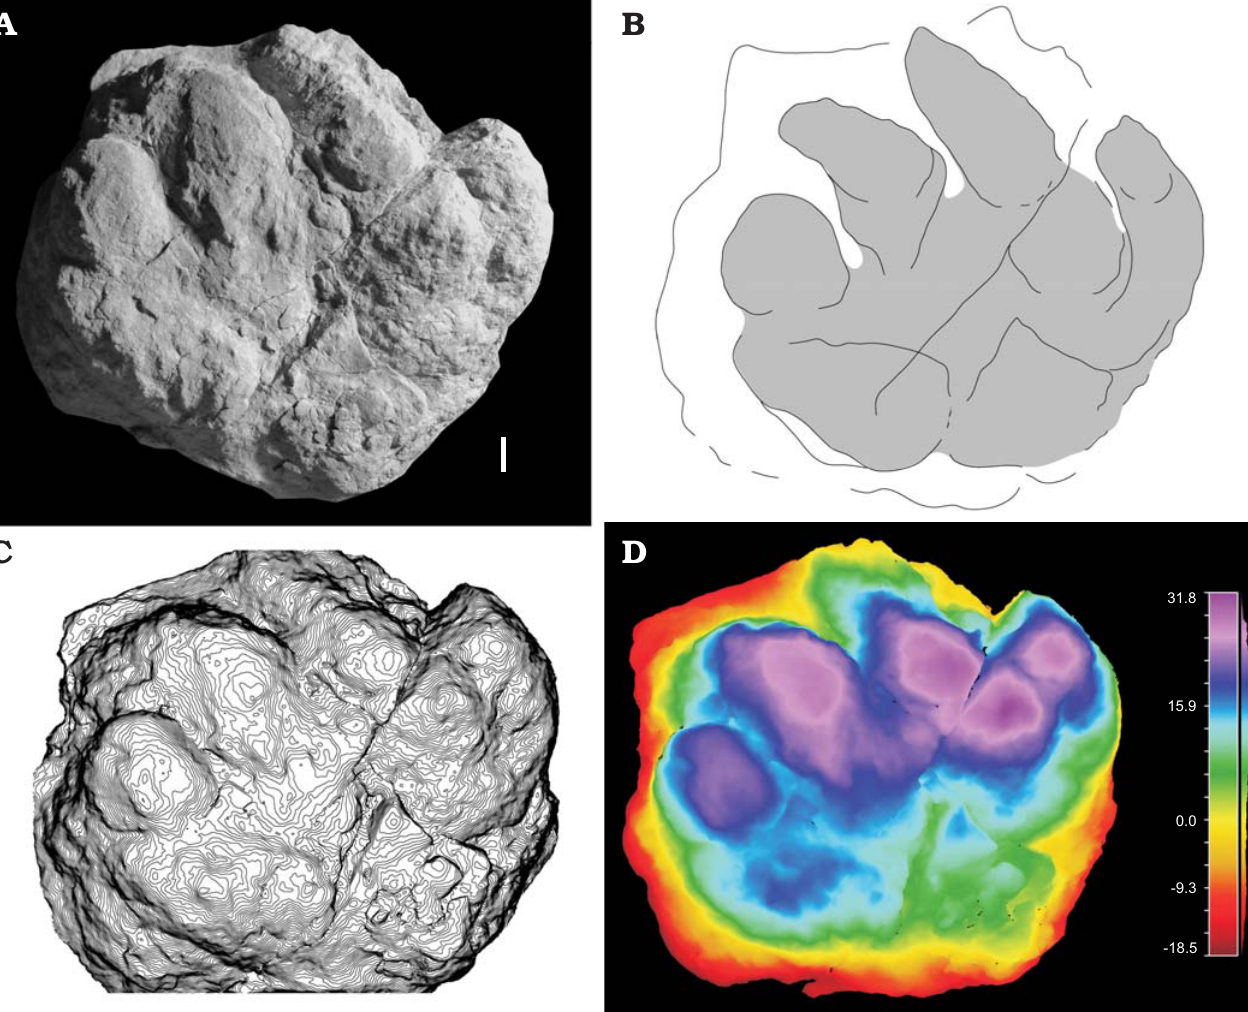
Fig. 5. Pareiasaurian parareptile trace Pachypes isp. (MCV 3) from Ulbe (Italy), Lopingian. Left manual imprint showing digits I–IV, convex hyporelief. Photo ( A ), interpretive drawing ( B ), false-color depth map ( C ), contour lines ( D ). Scale bar 10